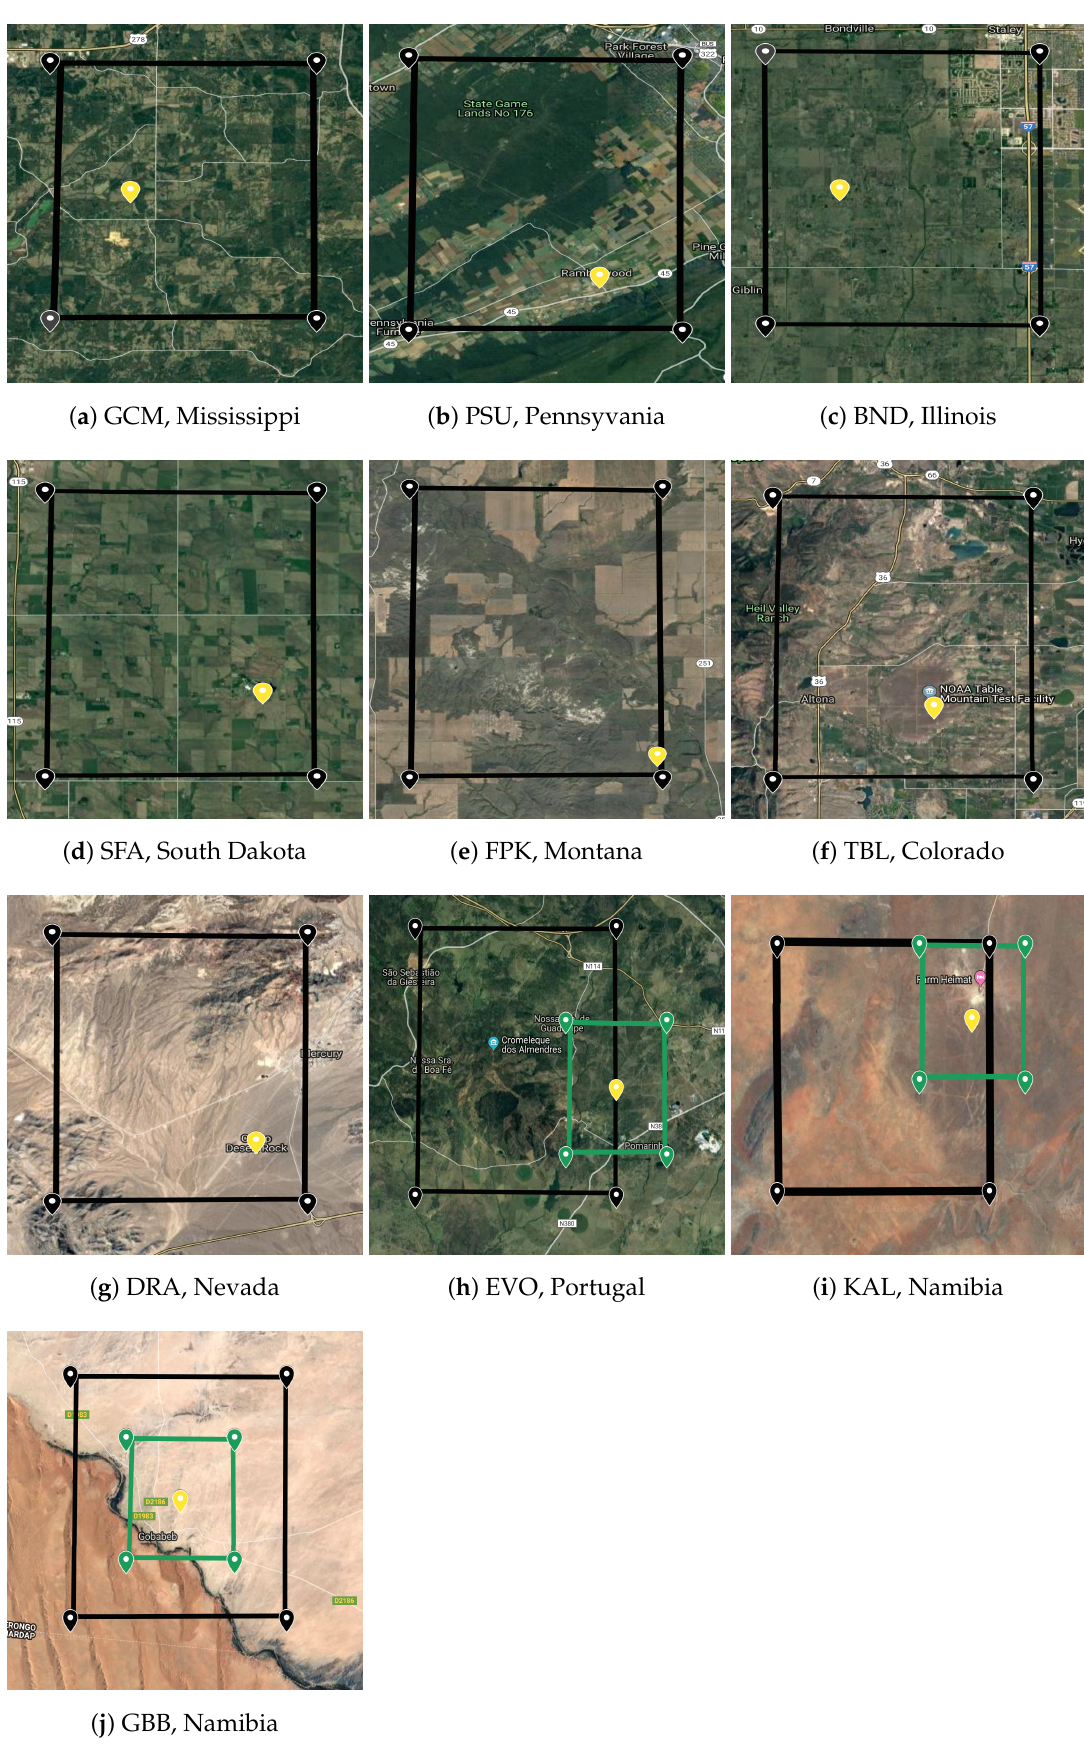
Figure 5. The locations of the ground stations and corresponding satellite pixel when available. Black: ISCCP pixel. Green: SEVIRI. Yellow: ground station. The satellite image is from Google map.